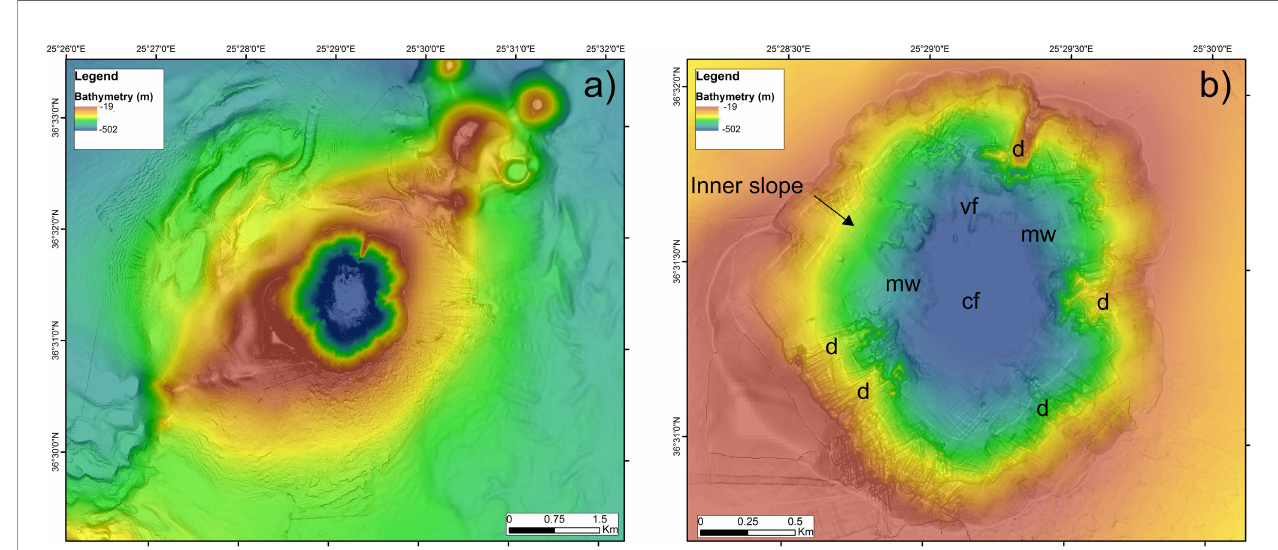
FIGURE 2 | (A) An AUV high-resolution bathymetric map of Kolumbo volcano (B) An AUV high-resolution map of Kolumbo crater (High resolution bathymetric data were collected by GEOMAR ’ s AUV Abyss during mission POS 510, Hannington, 2018). d, dyke; cf, crater fl oor; mw, mass wasting deposits; vf, vent fi